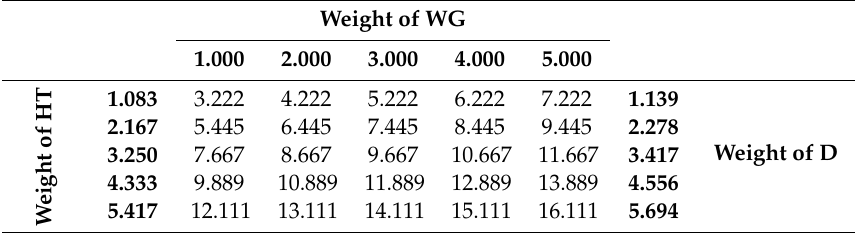
Figure 6. Percentage / area of categories of the case study area. HT = high temperature; D = drought risk; WG = wind gust. Table 9. Matrix of degrees of combined risk for D, HT, and WG based on their weight